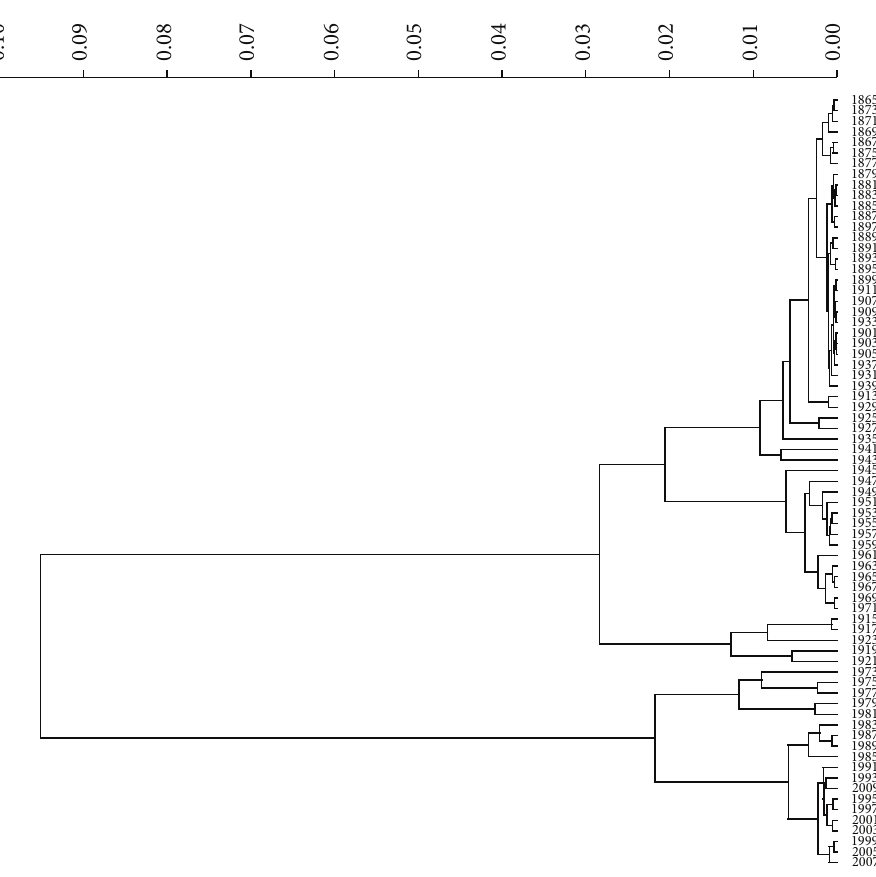
Figure 12: Dendrogram of the Portuguese economic evolution, in the perspective of the Cosine correlation 𝑟 𝐶 , 𝑇 = 1865 – 2010 , and ℎ = 2 years, clustering algorithm: unweighted